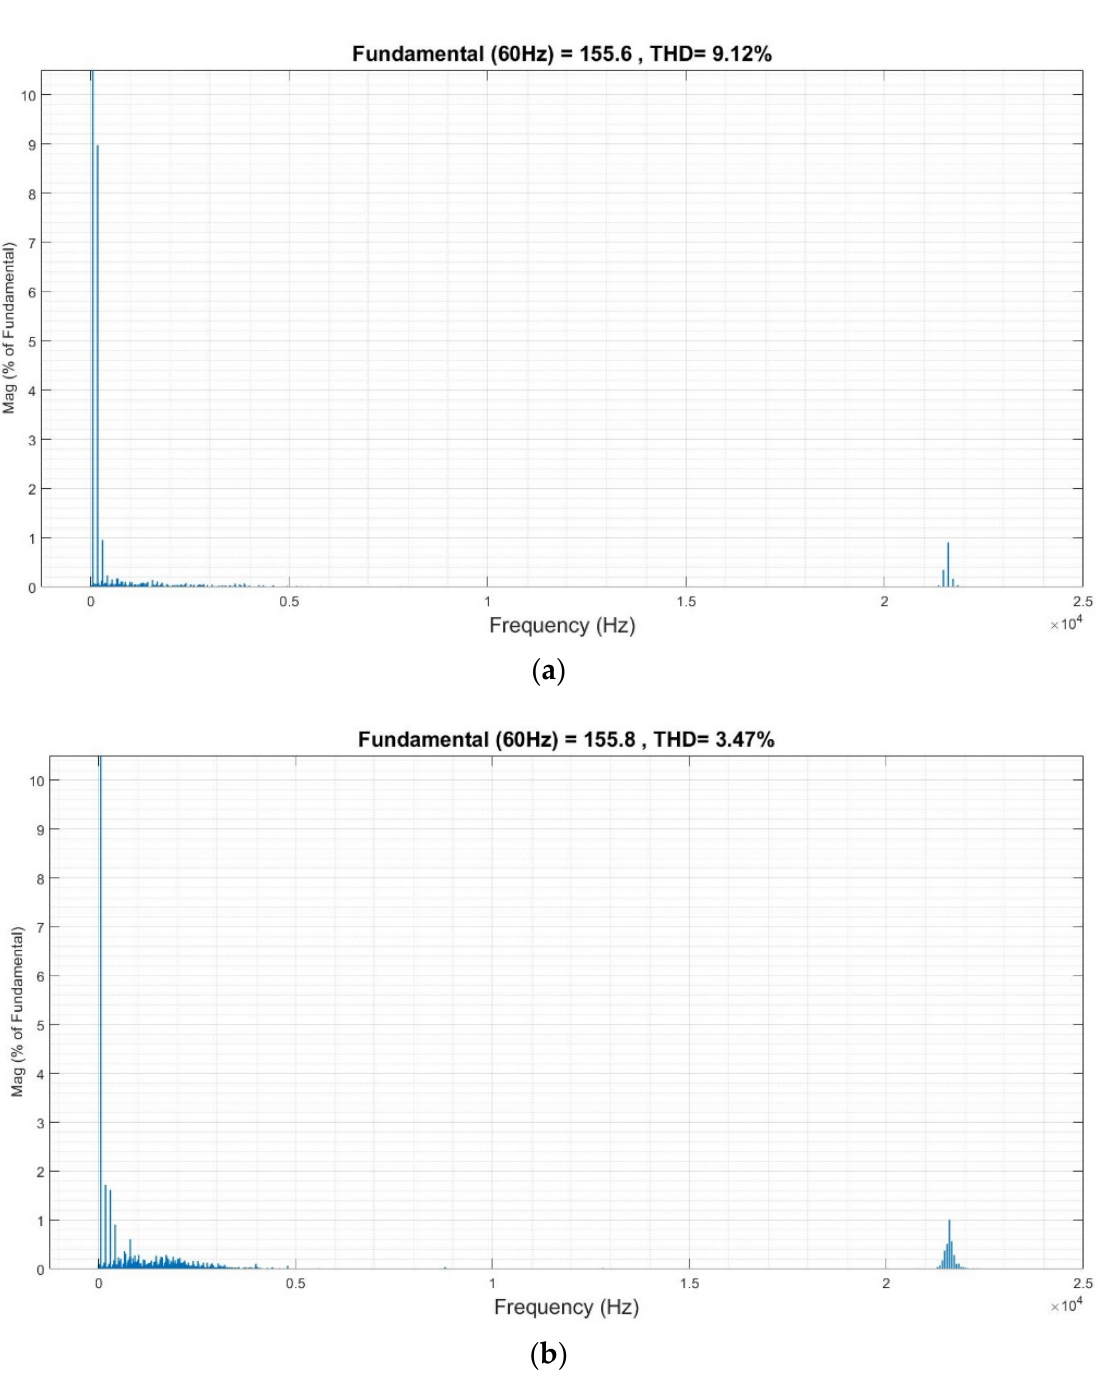
Figure 21. THD analysis of the simulation (250 W) when using ( a ) the traditional SPWM control and ( b ) modified SPWM control.